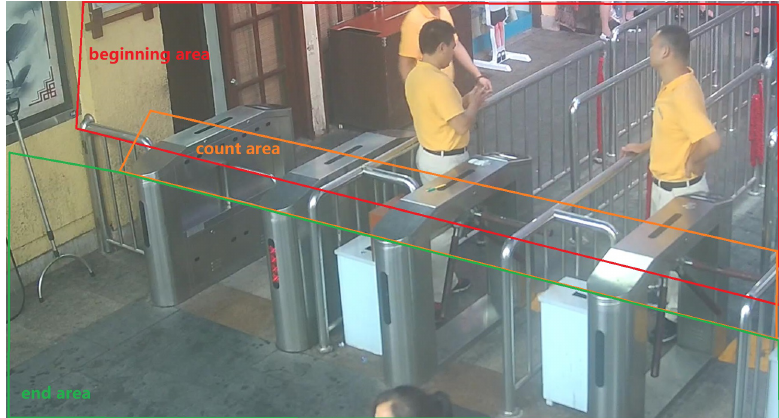
Figure 6. Virtual block-based method, pedestrian counting method.